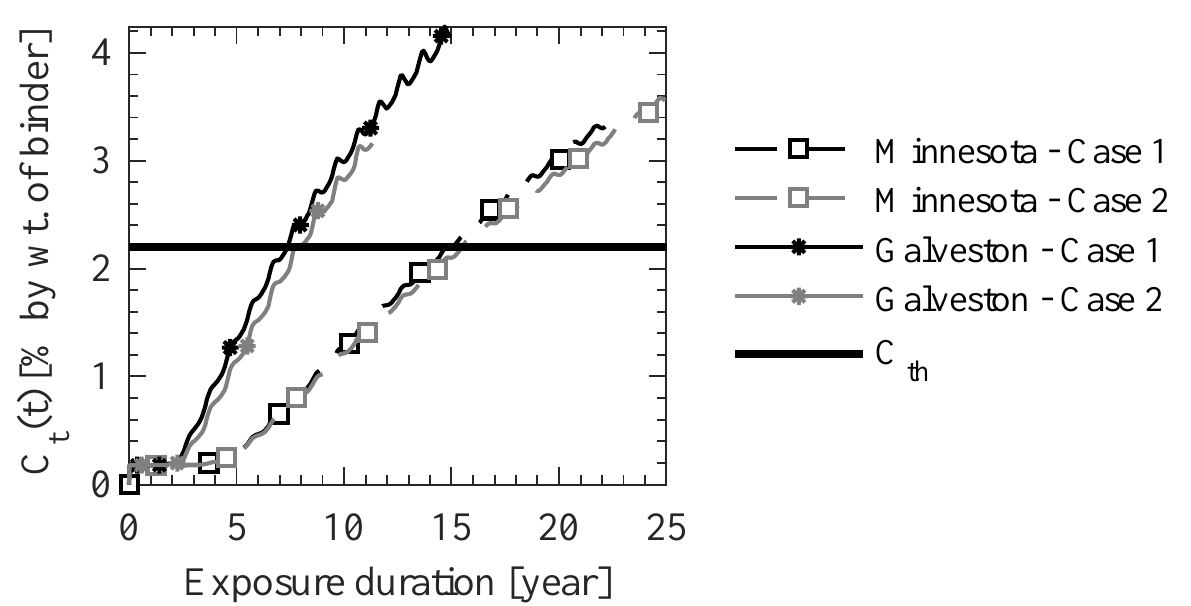
Figure 14. Temporal Cl − profiles in the concrete domain at the steel-concrete interface.